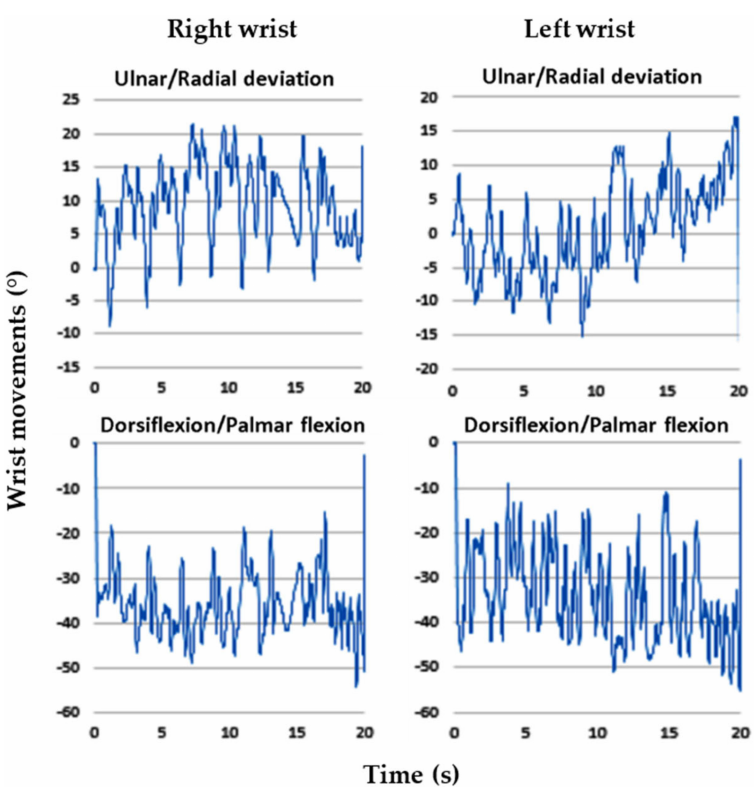
Figure 4. Alterations in wrist posture during the dough rod